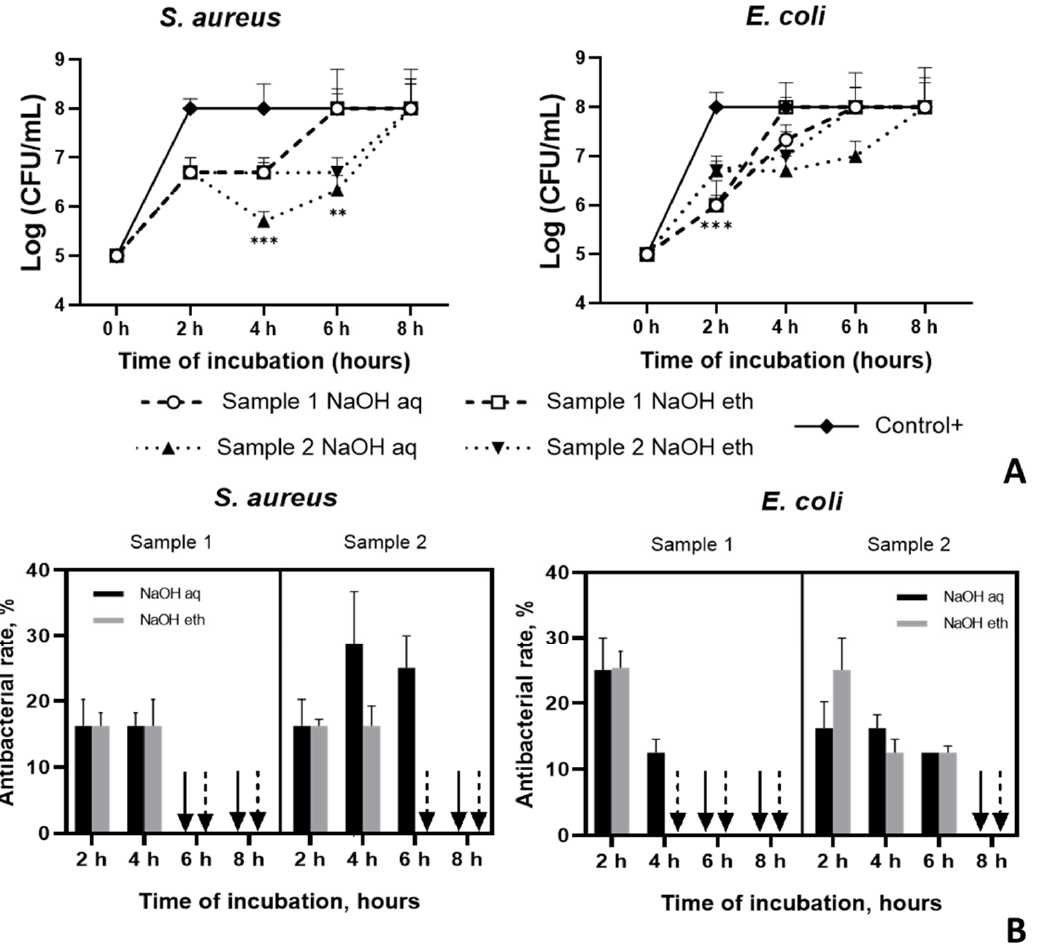
Figure 4. Antibacterial efficiency of chitosan membranes fabricated from TFA:DCM 7:3 and TFA:DCM 9:1 chitosan solutions against S. aureus and E. coli ; ( A ) the number of bacterial cells, CFU/mL; ( B ) the reduction rate, %.